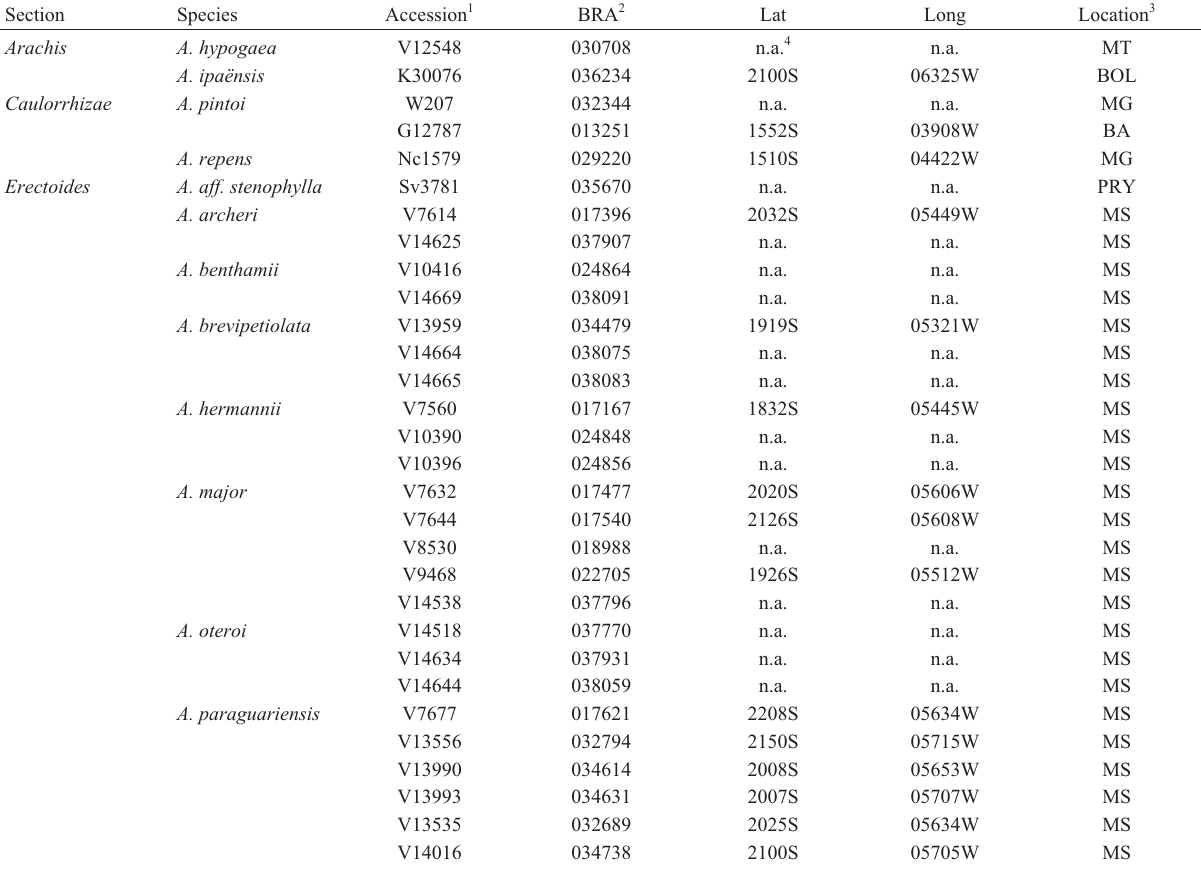
Table 1 - Accessions of 34 species from the nine Arachis sections that were investigated in this study.